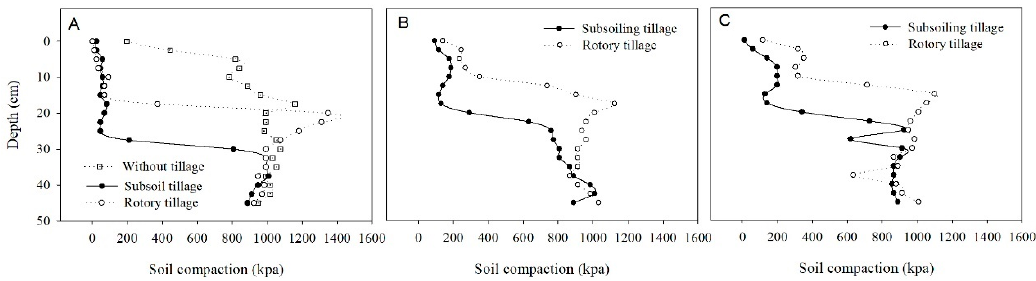
Figure 2. Soil compaction (kPa) at 0–50 cm depth in the experimental field in 2013. A , after tillage before sowing; B , the silking stage; C , the mature stage.